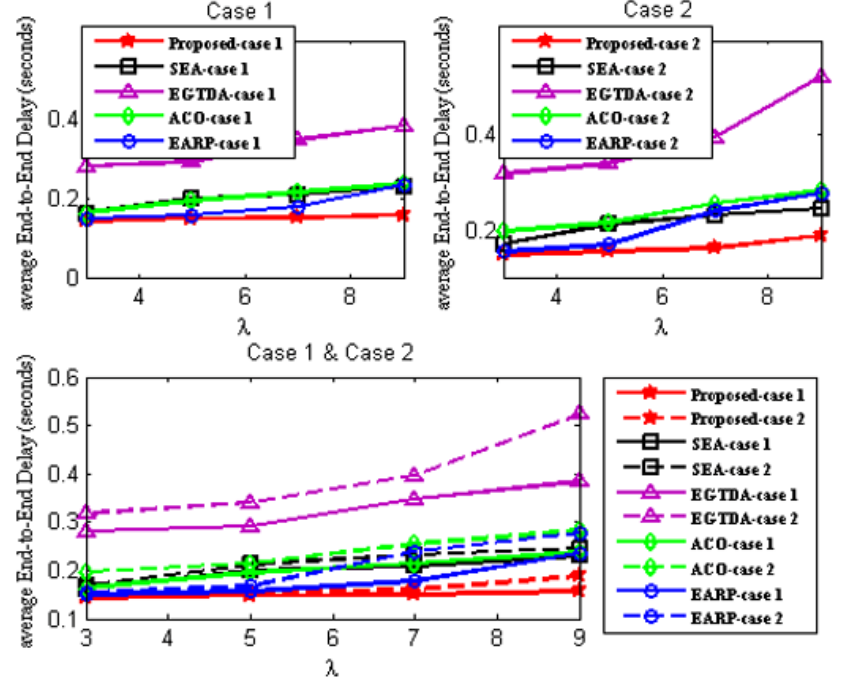
Figure 12. Influence of increasing average traffic rate on average end-to-end delay for the first sce-